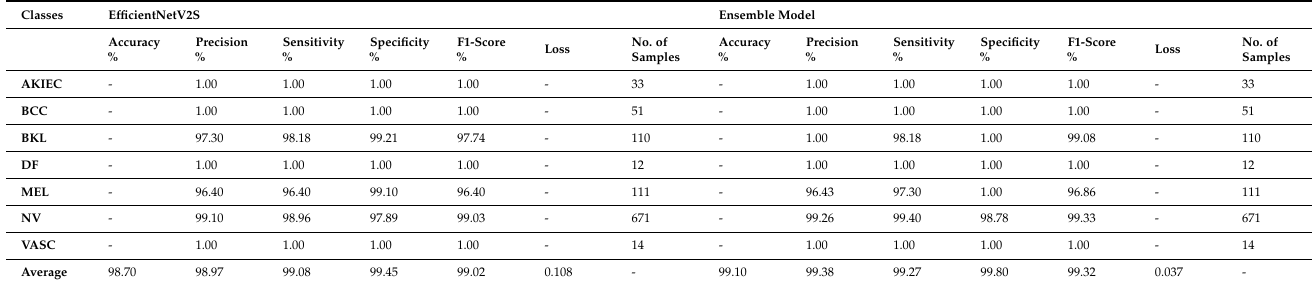
Table 2. Testing score of the EfficientNetV2S model and the ensemble